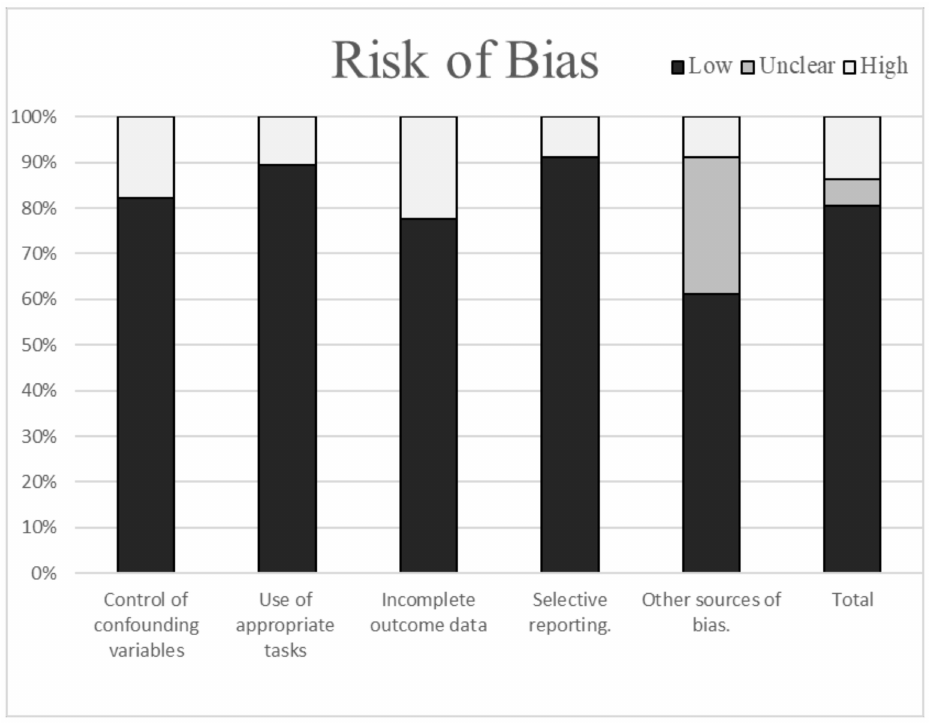
Figure 2. Risk of bias in the selected